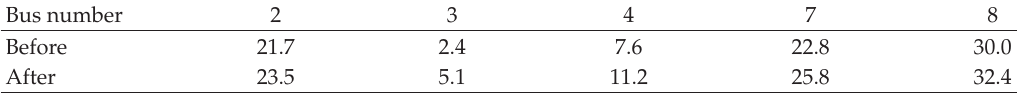
Table 3: Active loading of area